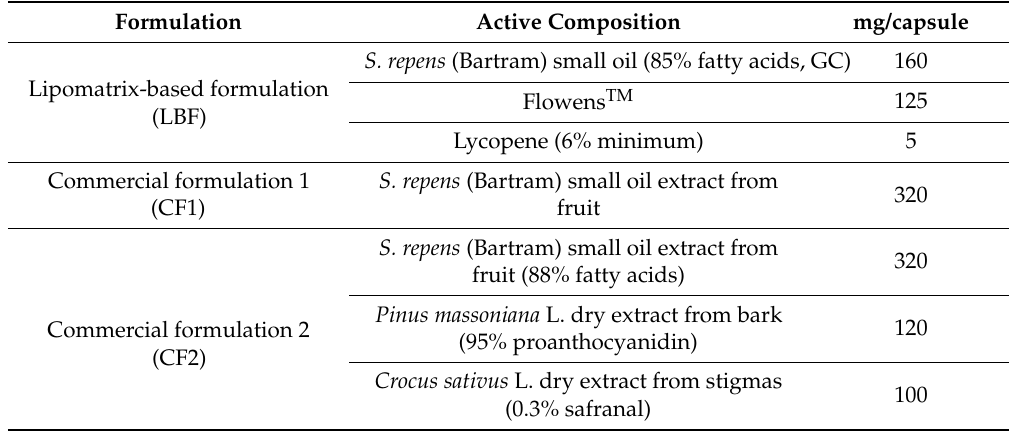
Table 7. List and composition of analyzed